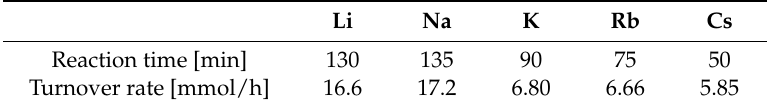
Table 1. Reaction times and turnover rates for the reaction of alkali metals with SF 6 . Li Na K Rb